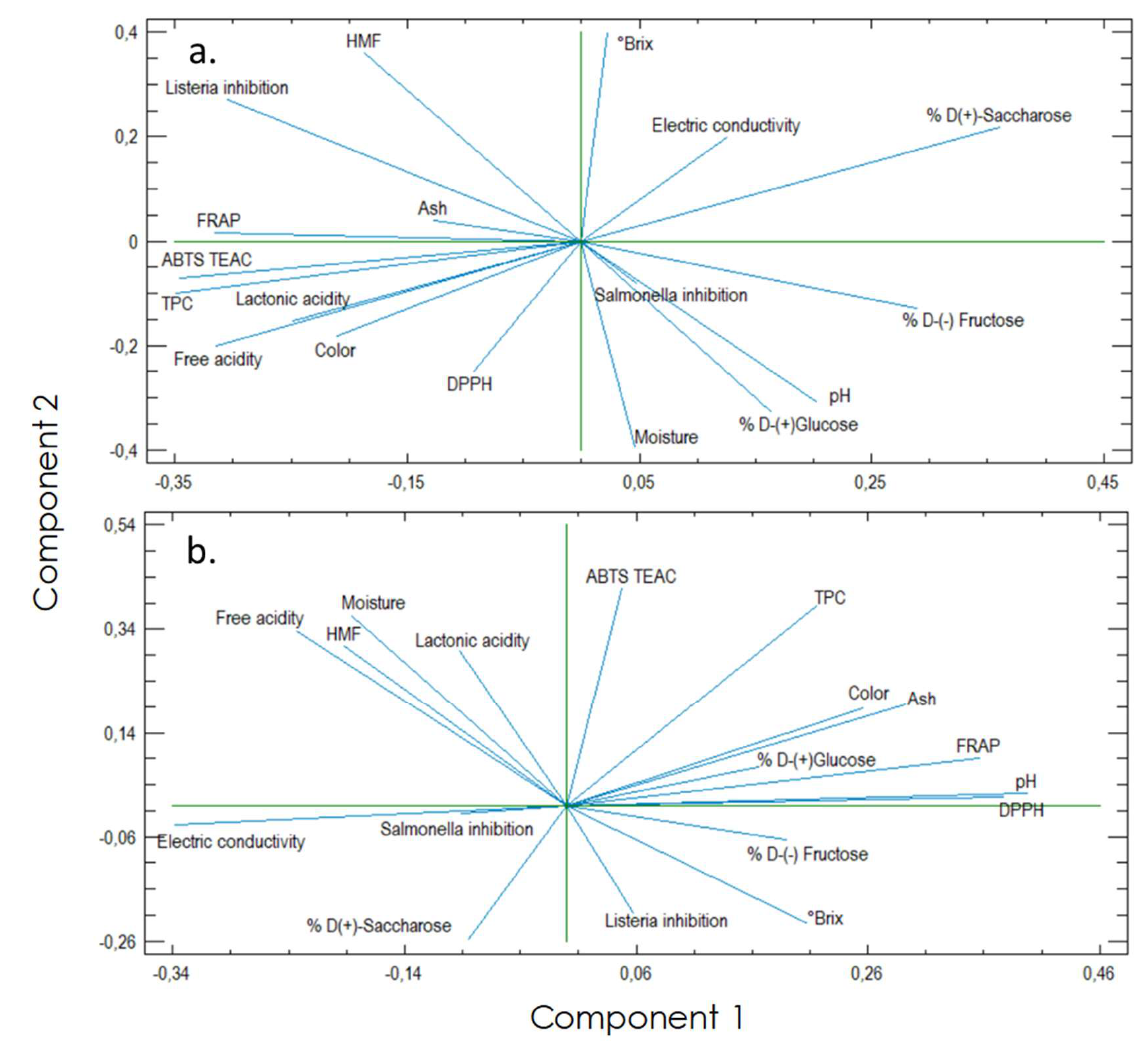
Figure 3. Principal component analysis of variables associated with the quality of honey produced by ( a ) Apis mellifera and ( b ) Melipona eburnea in Colombian forest.